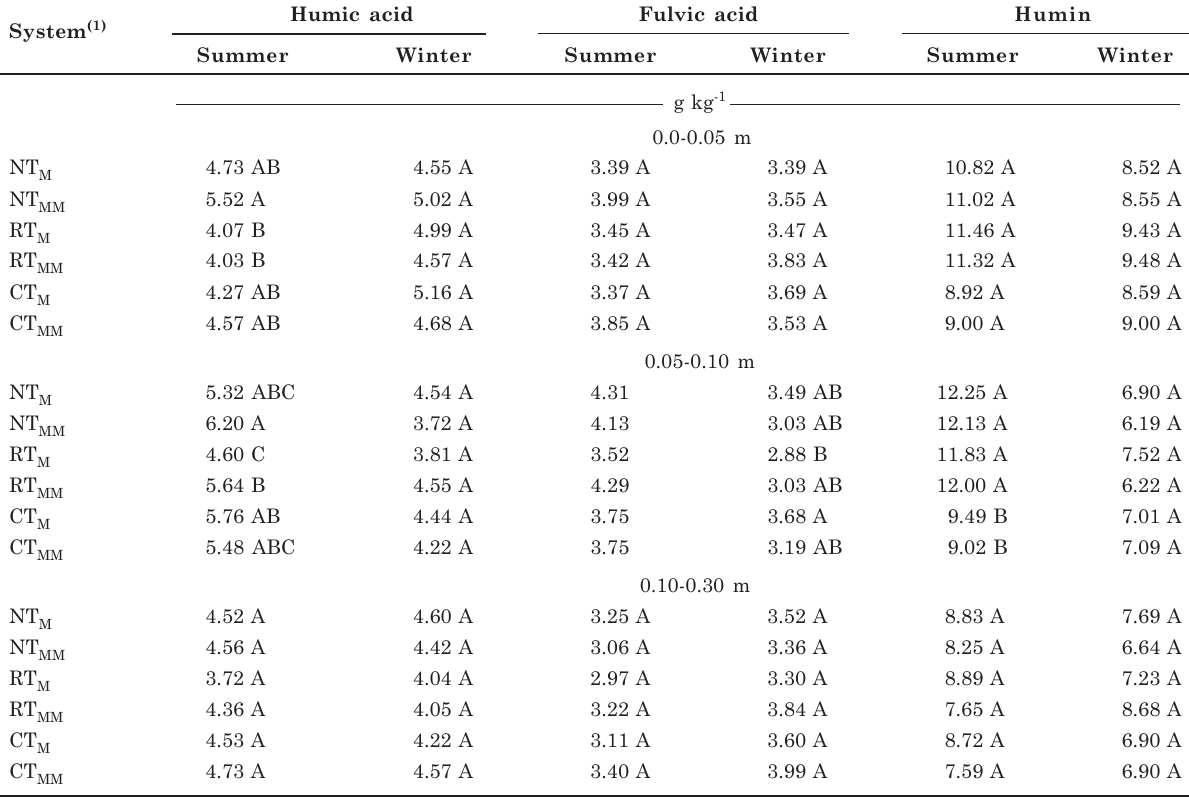
Table 5. Carbon of humic fractions in soil of different management systems, cover species, layers and sampling times